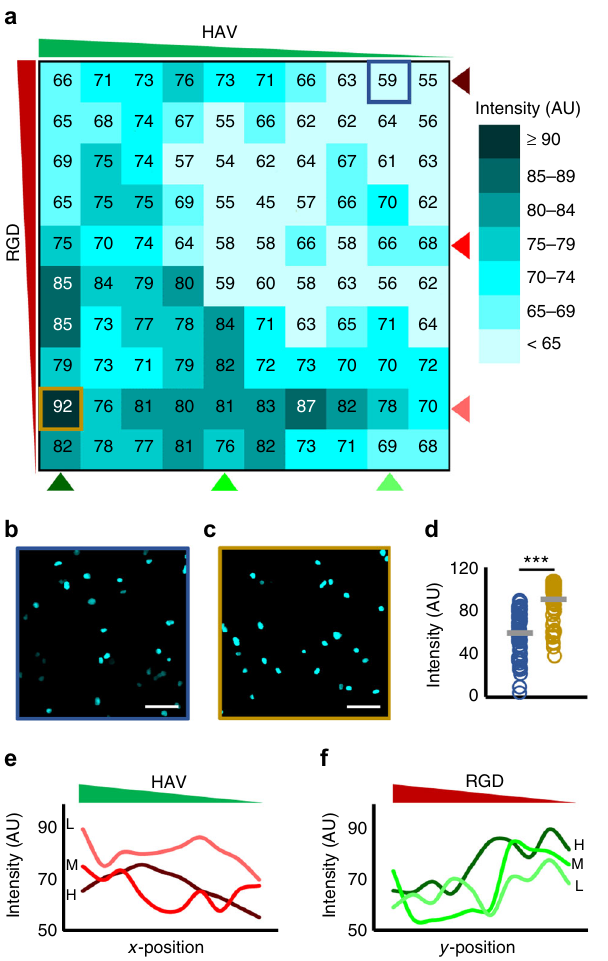
Fig. 6 Effects of orthogonal HAV and RGD gradients on aggrecan synthesis. a Heat map of synthesized aggrecan volumes across 100 bins (10 by 10 array) for analysis for cultures of mesenchymal stem cells (MSCs) after 7 days. Representative maximum projection images of bins corresponding to b high RGD, low HAV (outlined blue) and c low RGD, high HAV (outlined gold) qualitatively show lower and higher aggrecan volume, respectively. d Single-cell analysis of aggrecan volume for these same groups from b and c . e RGD curves at a constant concentration (light, medium, and dark red correspond to low “ L ” , medium “ M ” , and high “ H ” RGD concentrations, respectively) show a decreasing trend along HAV concentration gradient. In contrast, ( f ) HAV at a constant concentration (light, medium, and dark green correspond to low “ L ” , medium, “ M ” , and high “ H ” HAV concentrations, respectively) show an increasing trend along RGD concentration gradient, with highest aggrecan volume occurring along high HAV concentration curve at a low RGD concentration. n > 50 cells in samples shown in b and c , *** p < 0.001. Scale bars: 50 µ